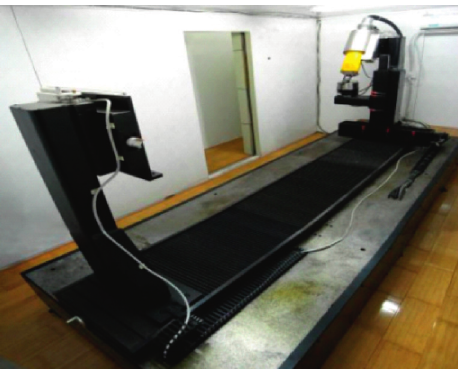
Figure 2: CT imaging system.